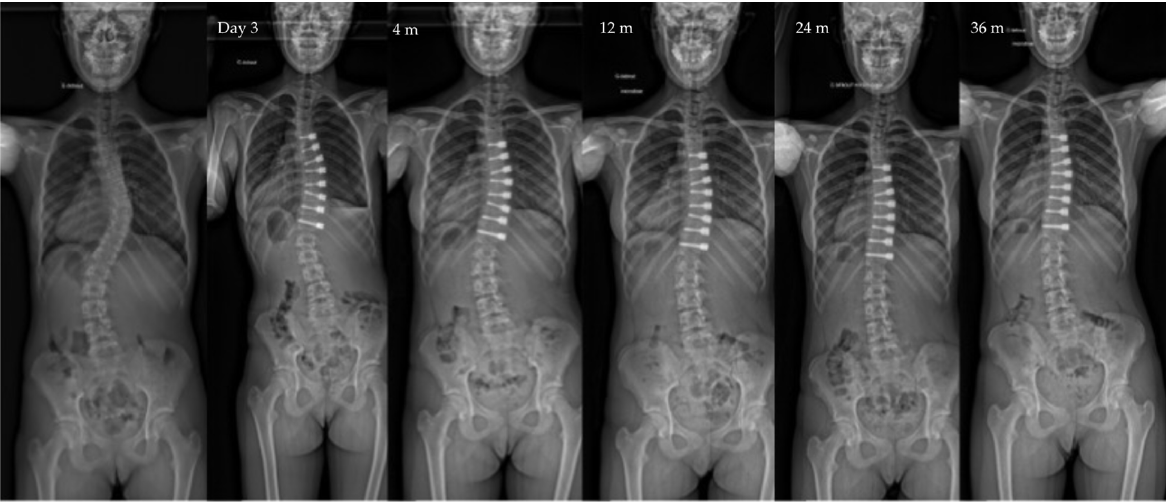
Figure 1. Radiographs of a 12-year-old patient, Risser 0, with a main thoracic curve. The major curve measured 46° pre-operatively, improved to 24° after surgery to 10° at last follow-up (3 y po—Risser 4). Note the spontaneous correction of the lumbar curve over time in this selective VBT.